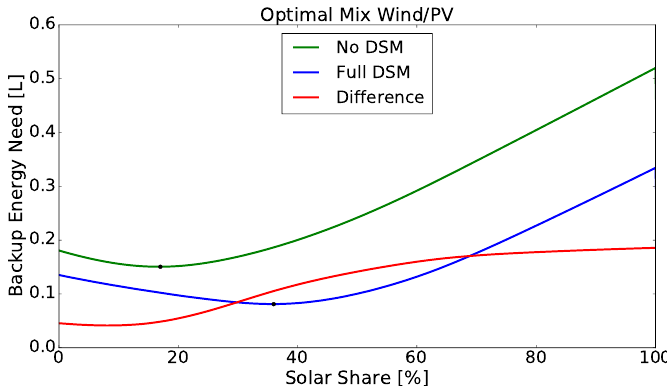
Figure 6. Backup energy need in dependency of the mix of wind and PV in Europe. Europe is treated like a copper plate. Black dots indicate the minima. The red line shows the difference between both curves. The backup energy need is measured in units of the overall